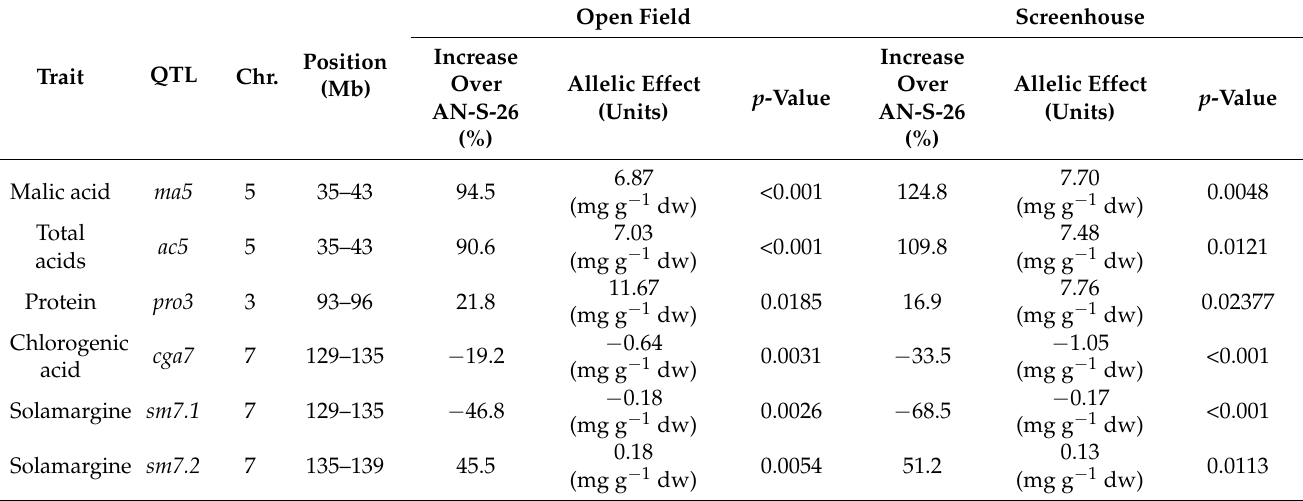
Table 3. List of stable (i.e., detected in both environments) putative QTLs detected in the eggplant IL population. All units are expressed on a dry weight basis